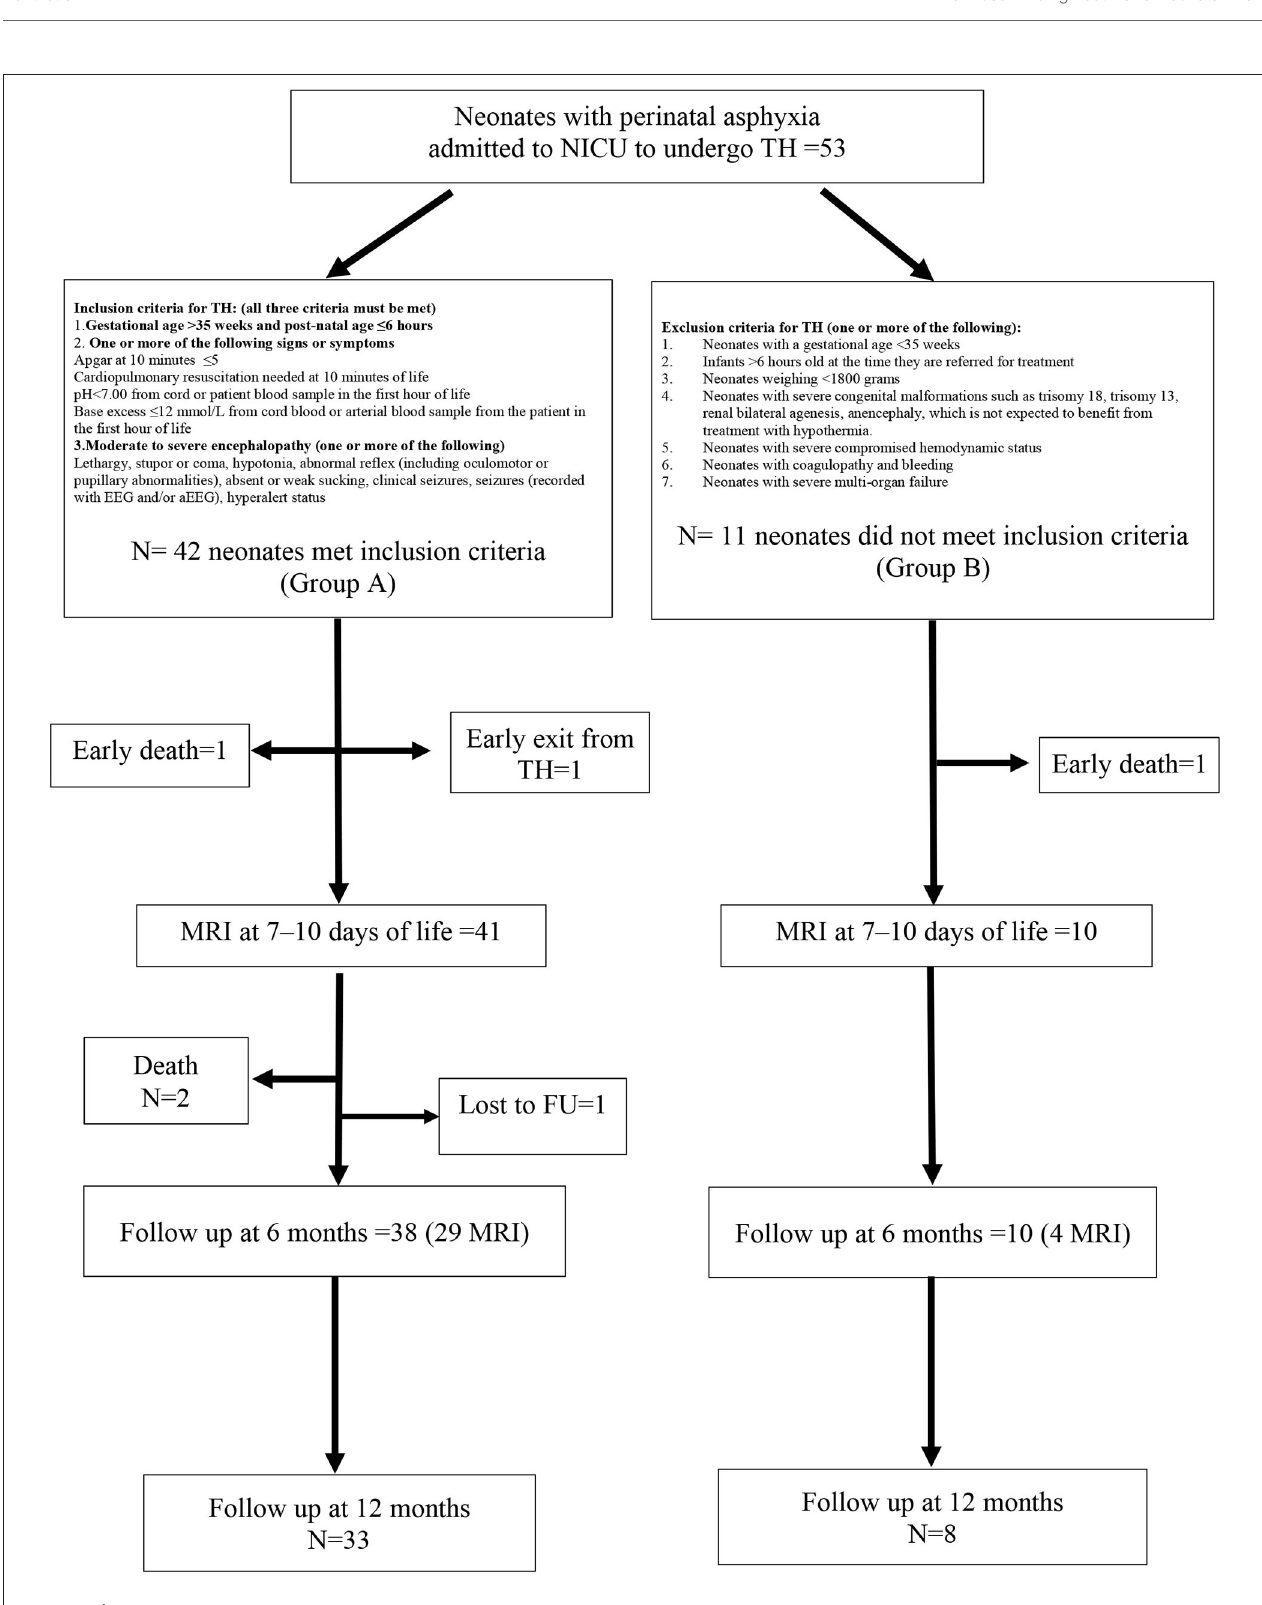
FIGURE 1 | Study flowchart with inclusion and exclusion criteria for therapeutic hypothermia (TH). Forty-two neonates (group A ) met inclusion criteria for hypothermia and 11 neonates (group B ) were out of the temporal window and were untreated.